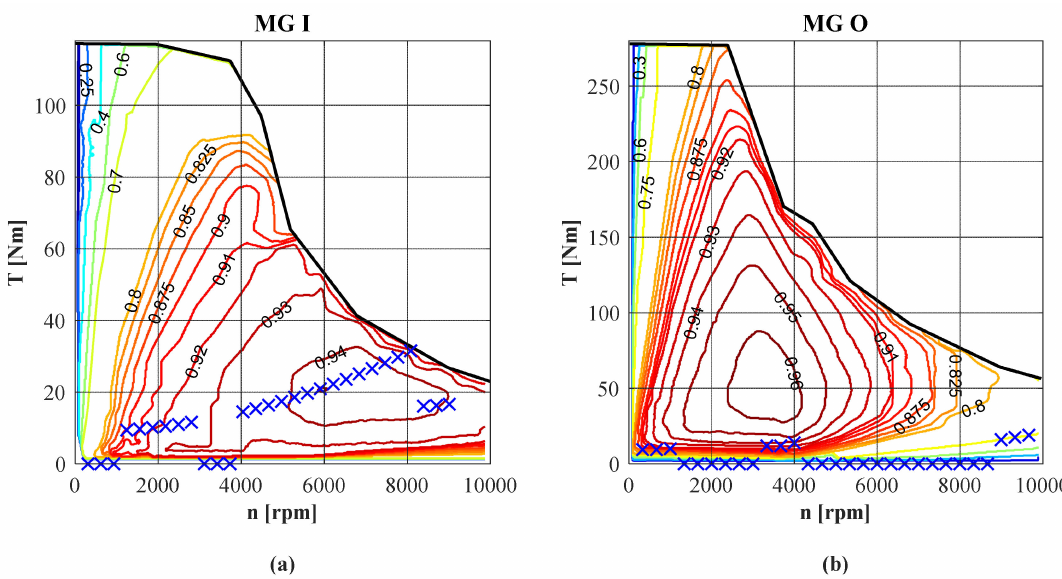
Figure 13. Electric machines optimal FEV operation, indicated by “X”: ( a ) MG I functioning points; ( b ) MG O functioning